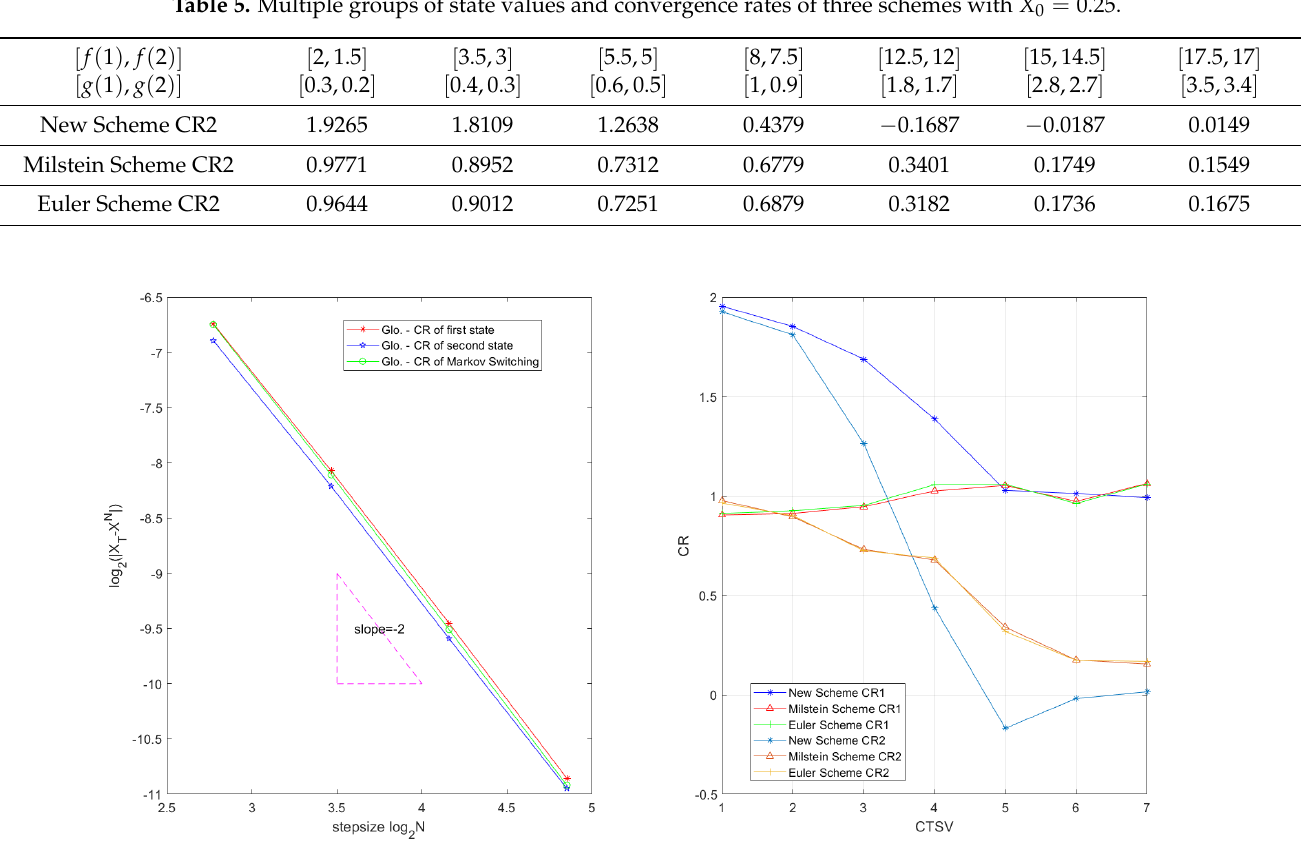
Figure 4. ( Left ) The convergence rates of different states. ( Right ) The variations in two methods of state values and the variations in the convergence rates of three